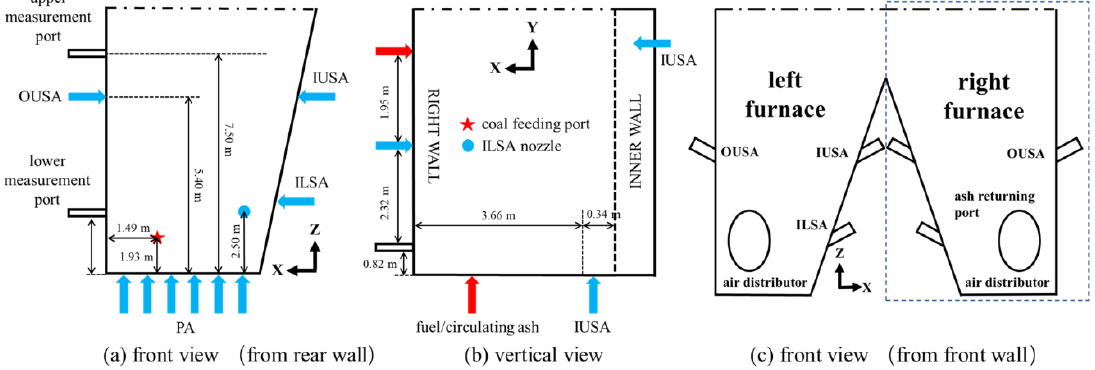
Figure 2. A schematic diagram of the upper / lower measurement ports and the air / coal feeding positions in adjacent zones (( a )-measurement ports from front view at the rear wall; ( b )-measurement port from vertical view; ( c )-arrangements of the secondary air and coal feeding port / ash returning port; ILSA-inner lower SA; IUSA-inner upper SA; OUSA-outer upper SA).